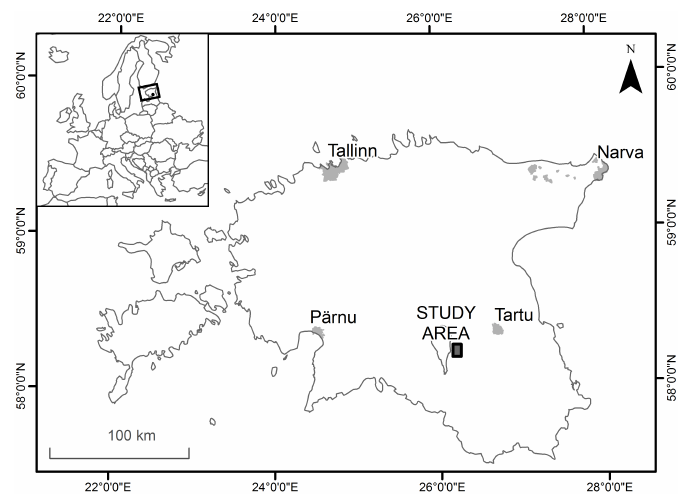
Figure 1. Location of the study area in Estonia.